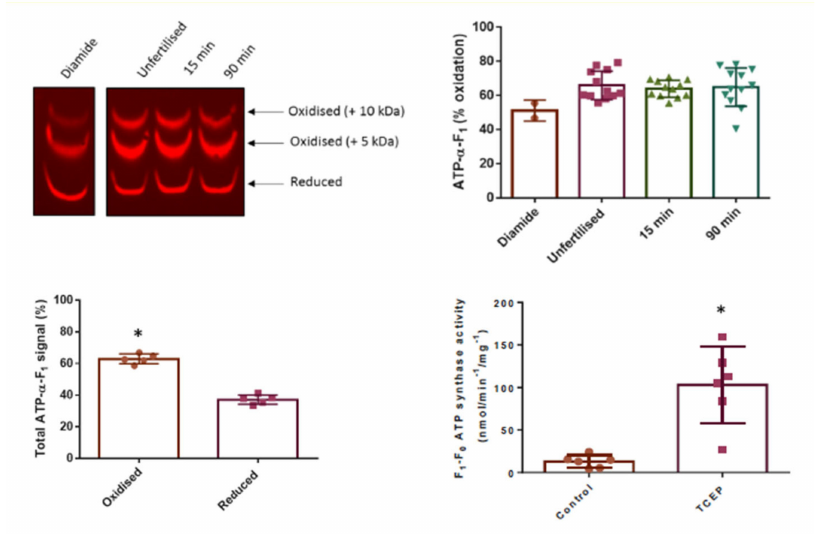
Figure 4. Reversible oxidation regulates mitochondrial ATP synthase activity in X. laevis